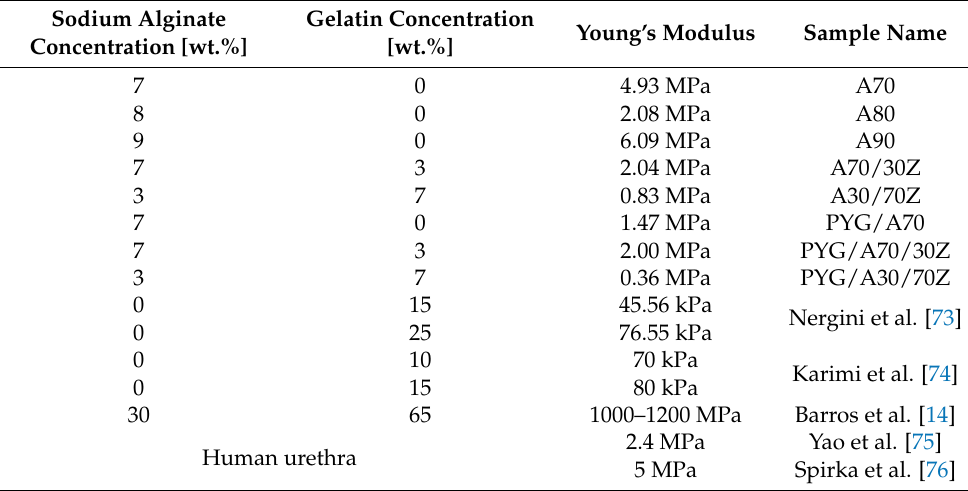
Table 1. Summary of Young’s Modulus values of the tested samples about those described in the literature and human urethra.